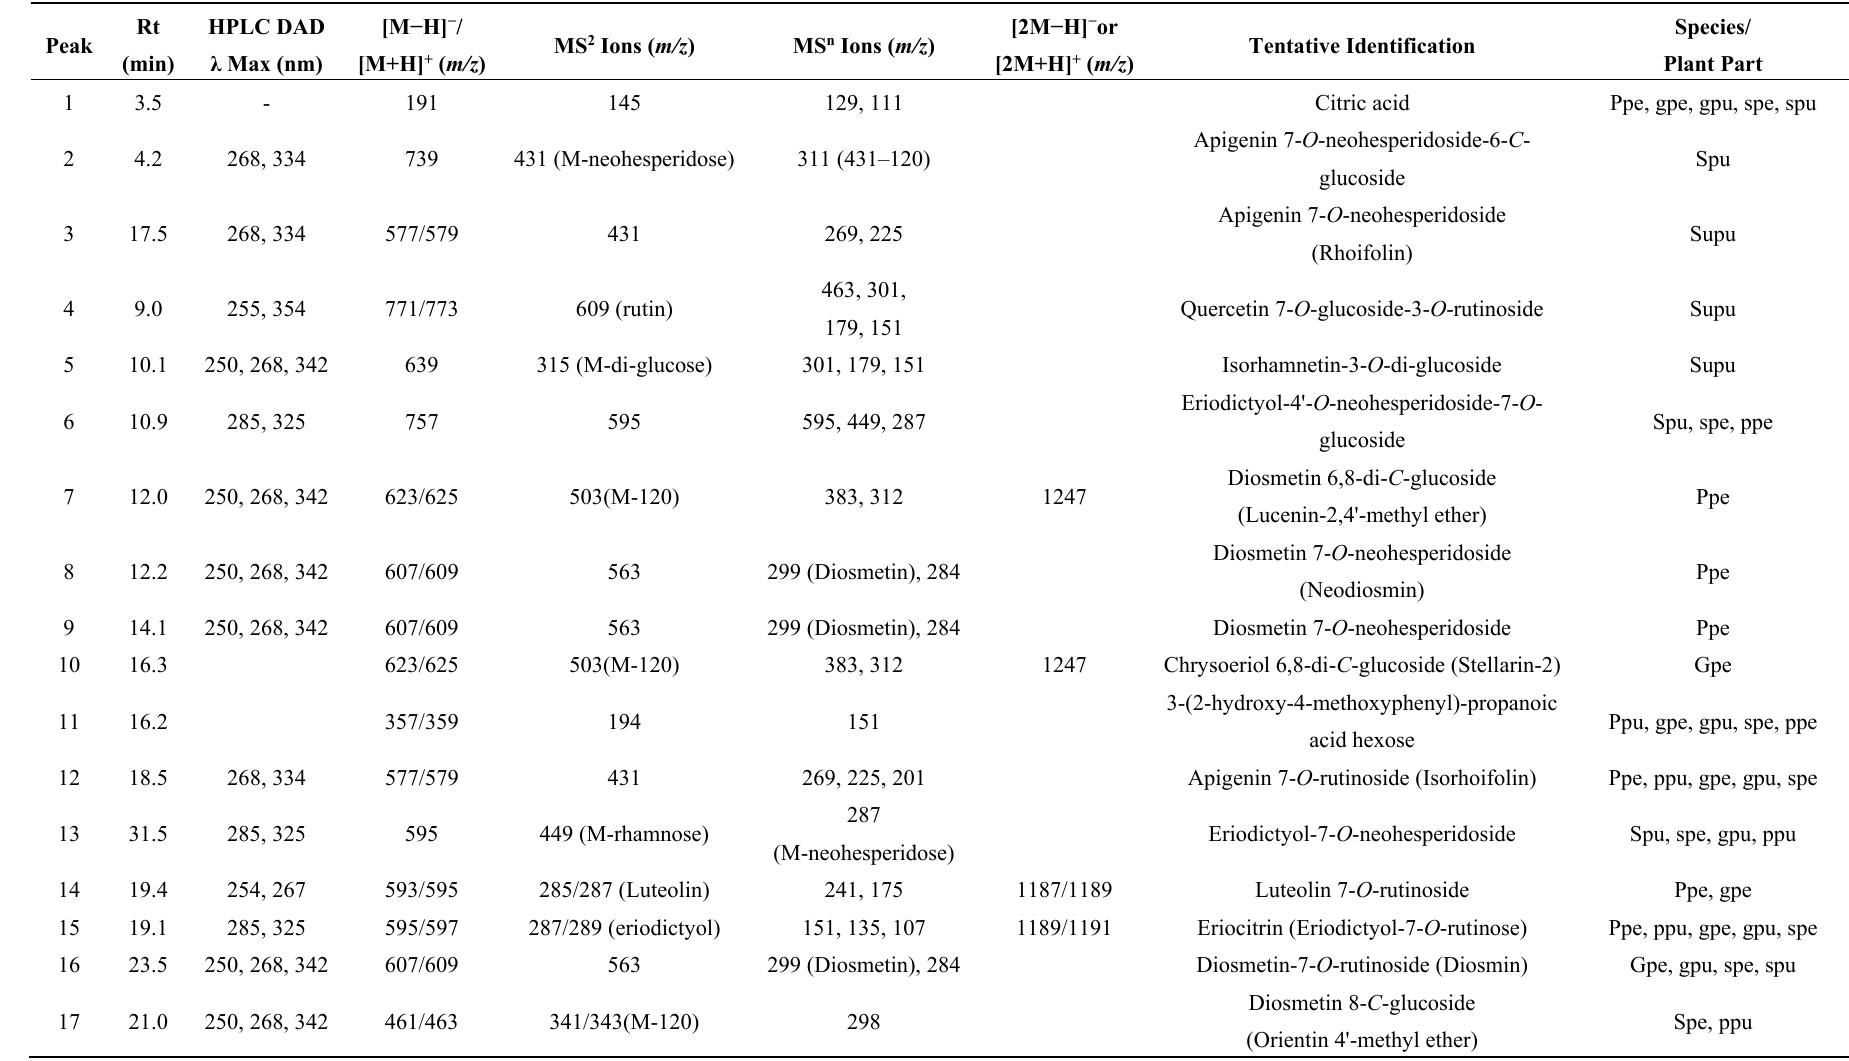
Table 1. Identification of phenolic compounds in Citrus fruits and aerial parts by LC-UV, LC-MS and MS/MS